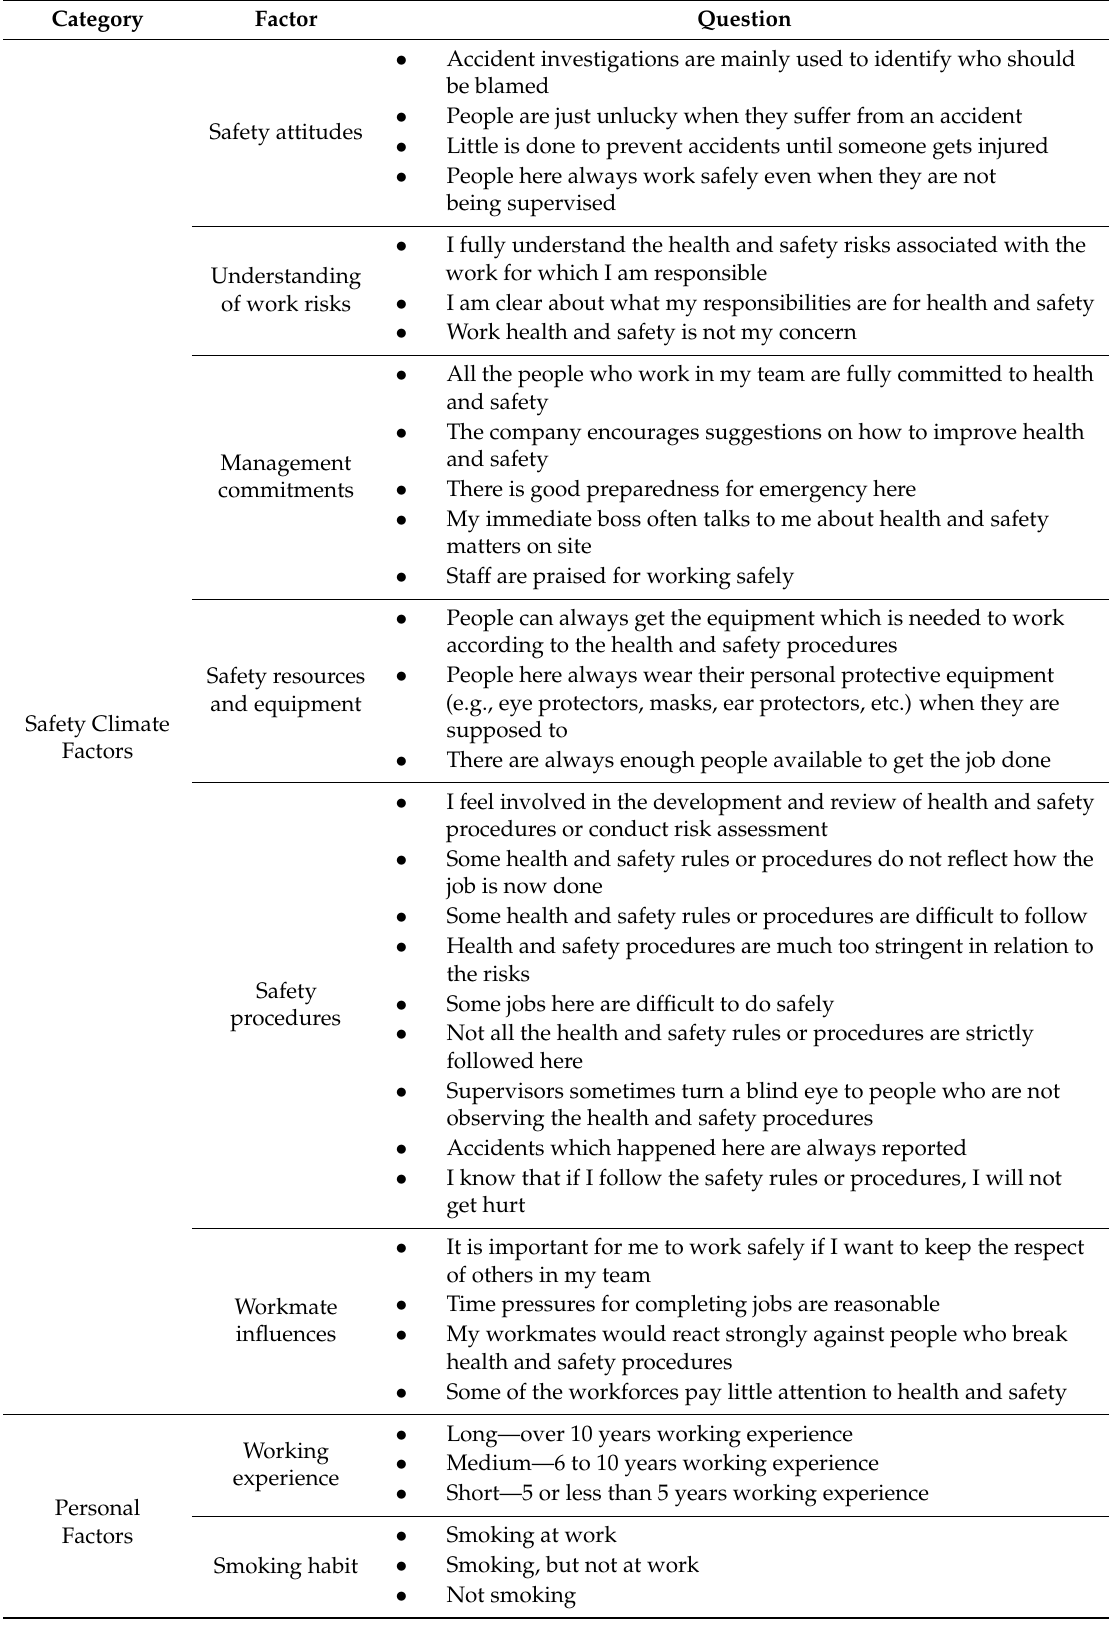
Table 2. Constructs of the Bayesian Network